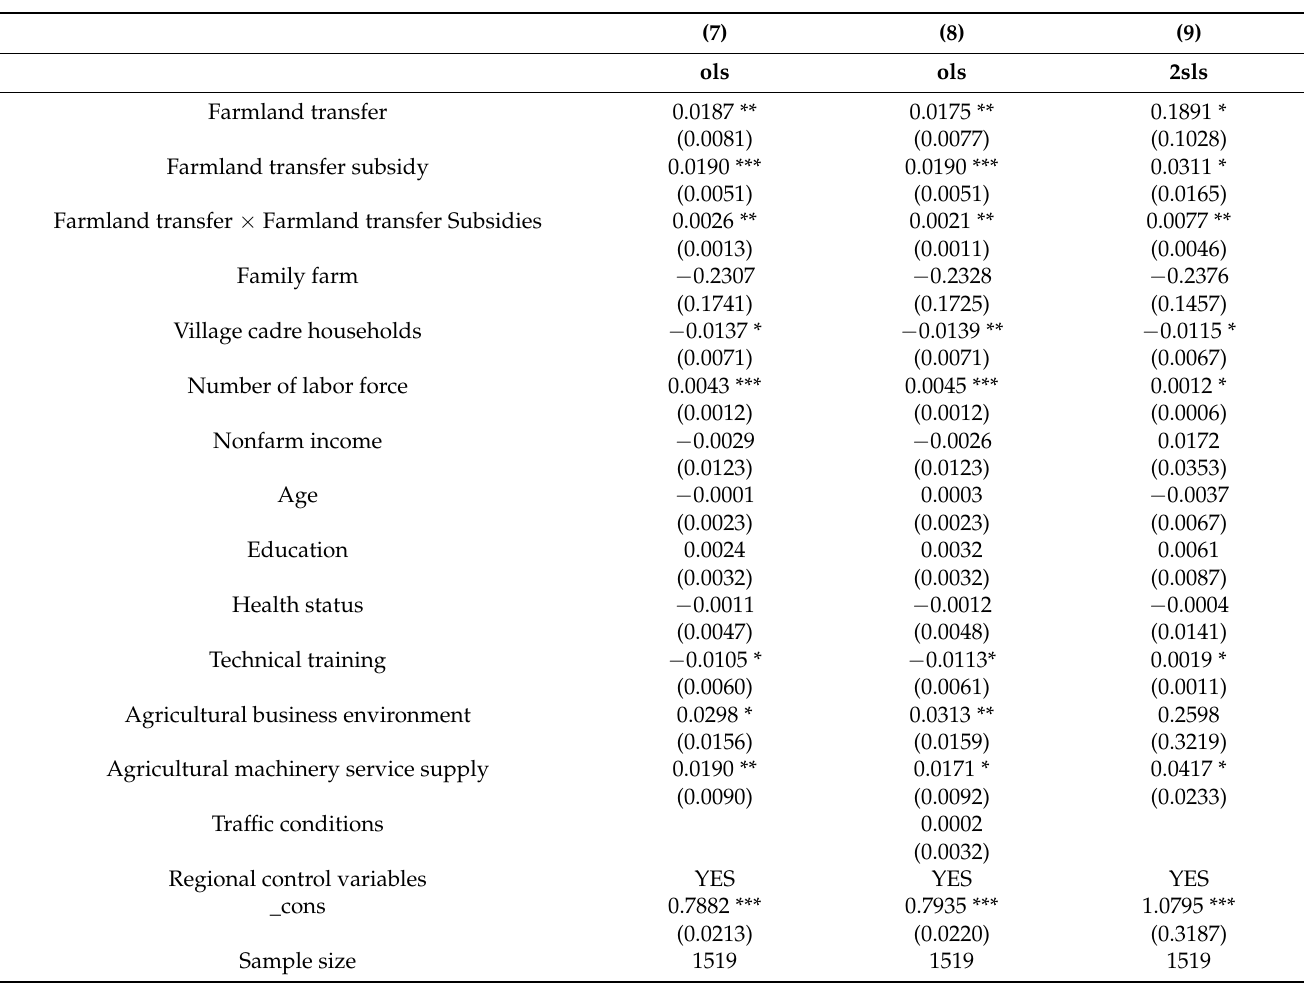
Table 5. The moderating effect of farmland transfer subsidies on farmland transfer on the technical efficiency of